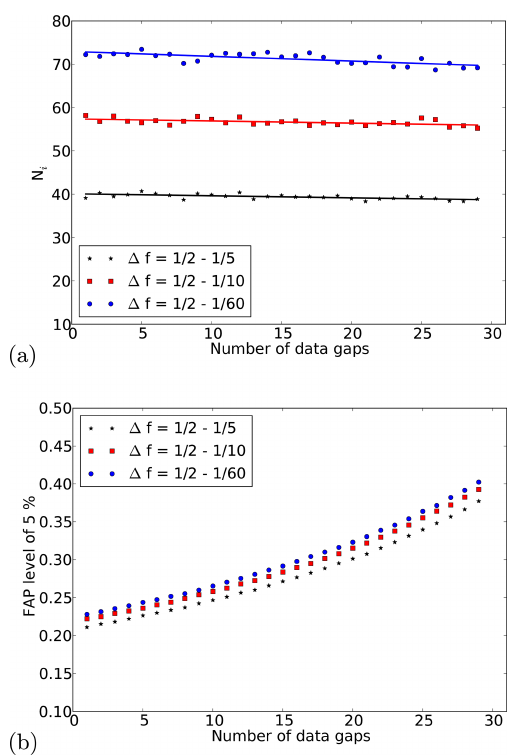
Figure 4. Dependency of N i and the FAP level of 5% on the num- ber of data gaps in a fixed time interval of length T . The analysed frequency ranges are 1 / 2–1 / 5, 1 / 2–1 / 10, and 1 / 2–1 / 60d − 1 , and the time interval length is